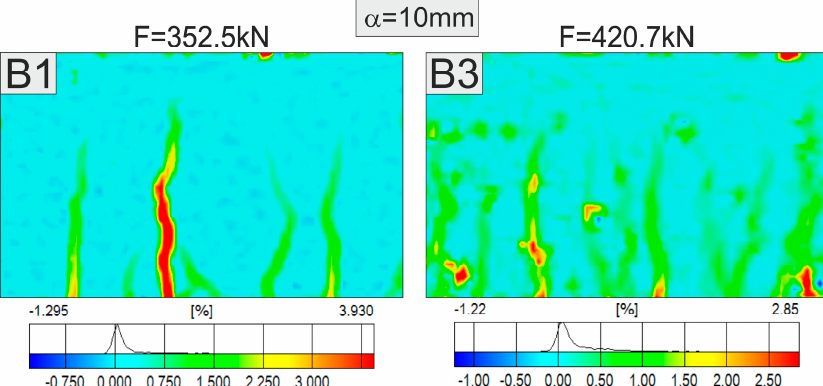
Figure 13. Comparison of major strains for B1 and B3 beams in measurement area, at deflection of 10 mm.